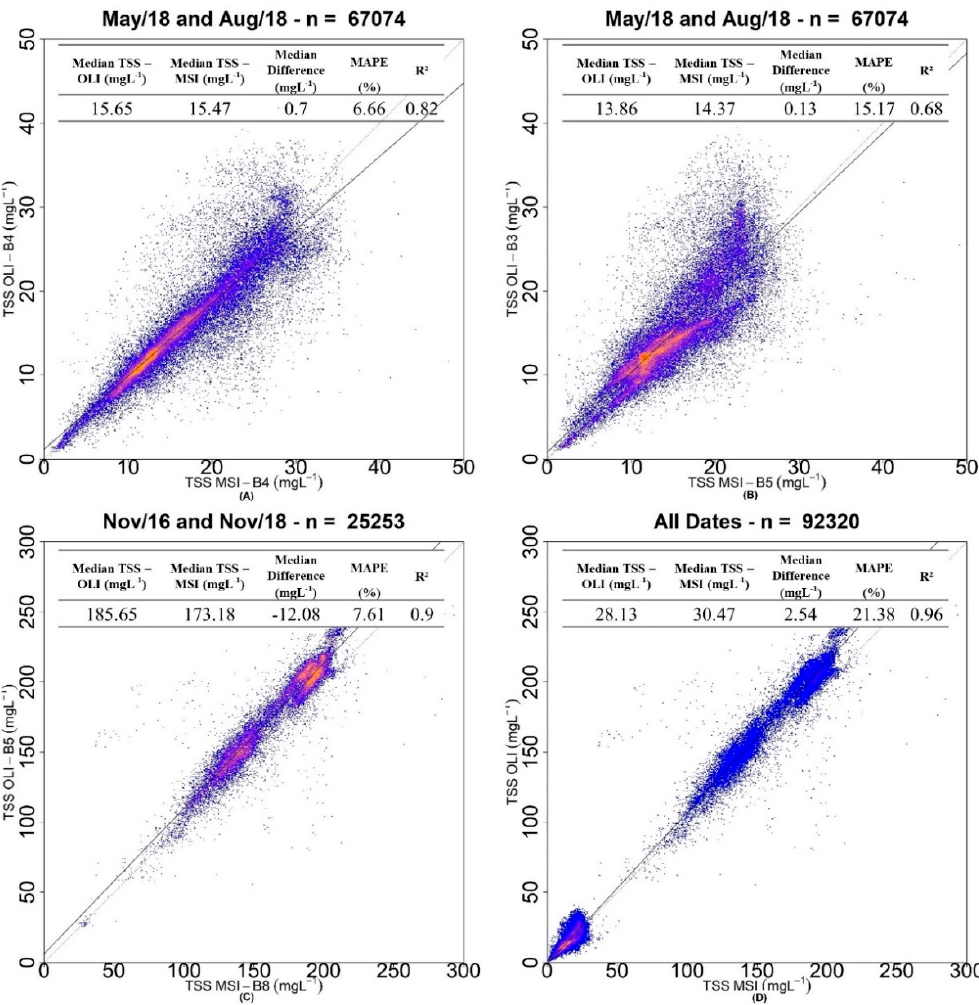
Figure 14. The density scatterplots for TSS products derived from OLI and MSI scenes using: ( A ) calibrated algorithms for red OLI and MSI bands applied to high-water period images; ( B ) calibrated algorithms for OLI-B3 and MSI-B5 bands applied to high-water period images; ( C ) calibrated algorithms for NIR bands (OLI-B5 and MSI-B8) applied to low-water period images; and ( D ) calibrated algorithms applied for the four scenes using OLI-B3 and MSI-B5 for high-water periods and OLI-B5 and MSI-B8 for low-water periods. The top box at each figure refers to the statistical metrics median, MD, MAPE, and R 2 . The colored points indicate the density of the points: blue for low point density and magenta-yellow for high point